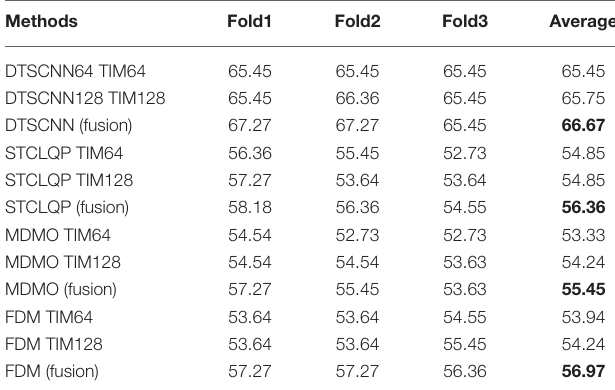
TABLE 4 | The micro-expression recognition results (%) on CASMEI/II dataset with different methods, the fusion in bracket denotes the result is computed after done the decision-level fusion using Equation